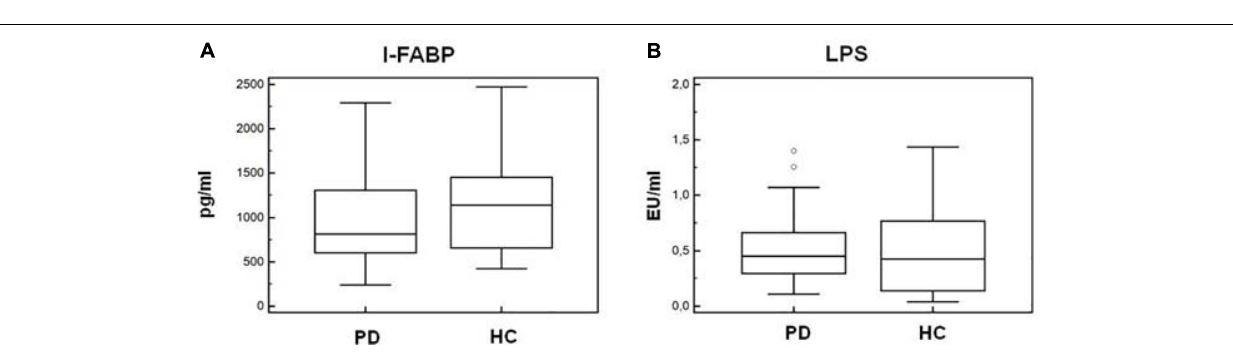
FIGURE 9 | Plasma I-FABP and LPS concentration. Microbial translocation and gut barrier permeability markers. I-FABP (A) and LPS (B) concentration (pg/mL and EU/mL, respectively) in plasma of Parkinson disease patients (PD, n = 15) and healthy controls (HC, n = 15). Summary results are shown in the bar graphs. The boxes stretch from the 25th to the 75th percentile; the line across the boxes indicates the median values; the lines stretching from the boxes indicate extreme values. Outside values are displayed as separate